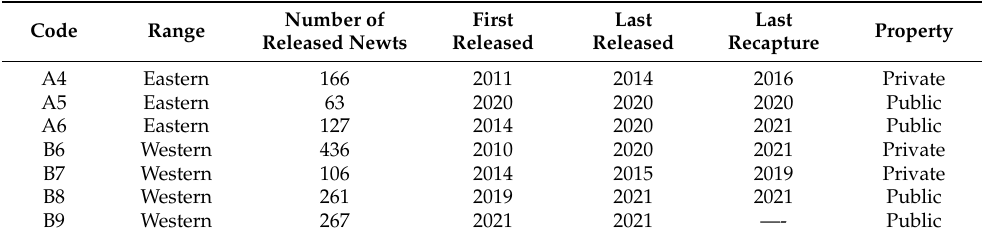
Table 4. New populations established in the C. arnoldi potential area of distribution. Only population codes are written because of conservation policies for this CR species. Range: slope location in La Tordera river basin. First release: year when first release was made. Last released: last booster. Last recapture: year when C. arnoldi was captured in the stream. Property: Land property where the new population and stream stretch are